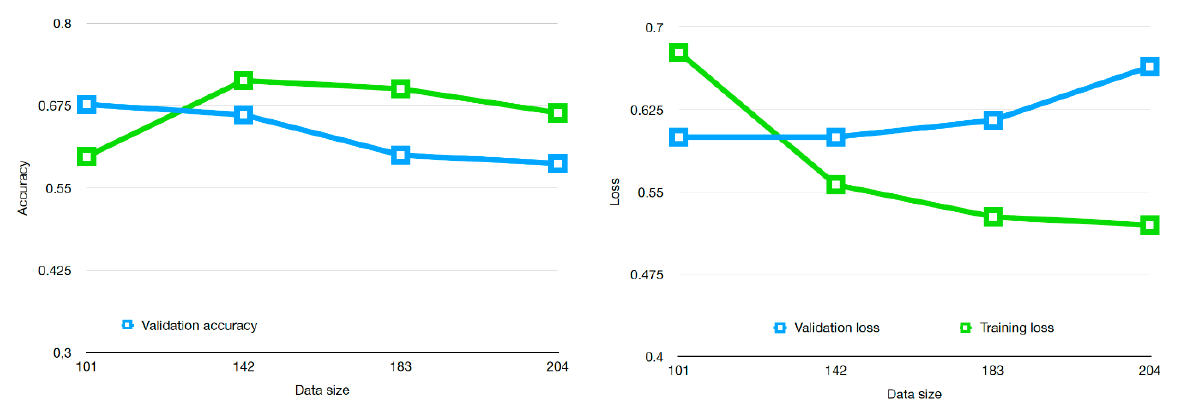
Figure 8. Learning curves for training and validation loss and accuracy, with varying labeled sample set sizes, for the one-week-long input geomagnetic time series.